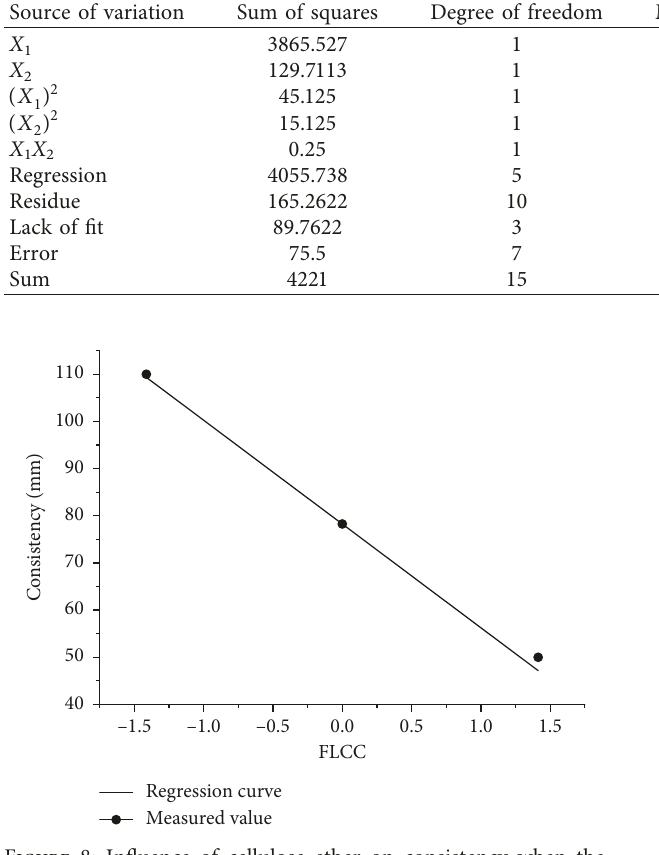
Figure 8: Influence of cellulose ether on consistency when the substitution rate of rubber is 0.